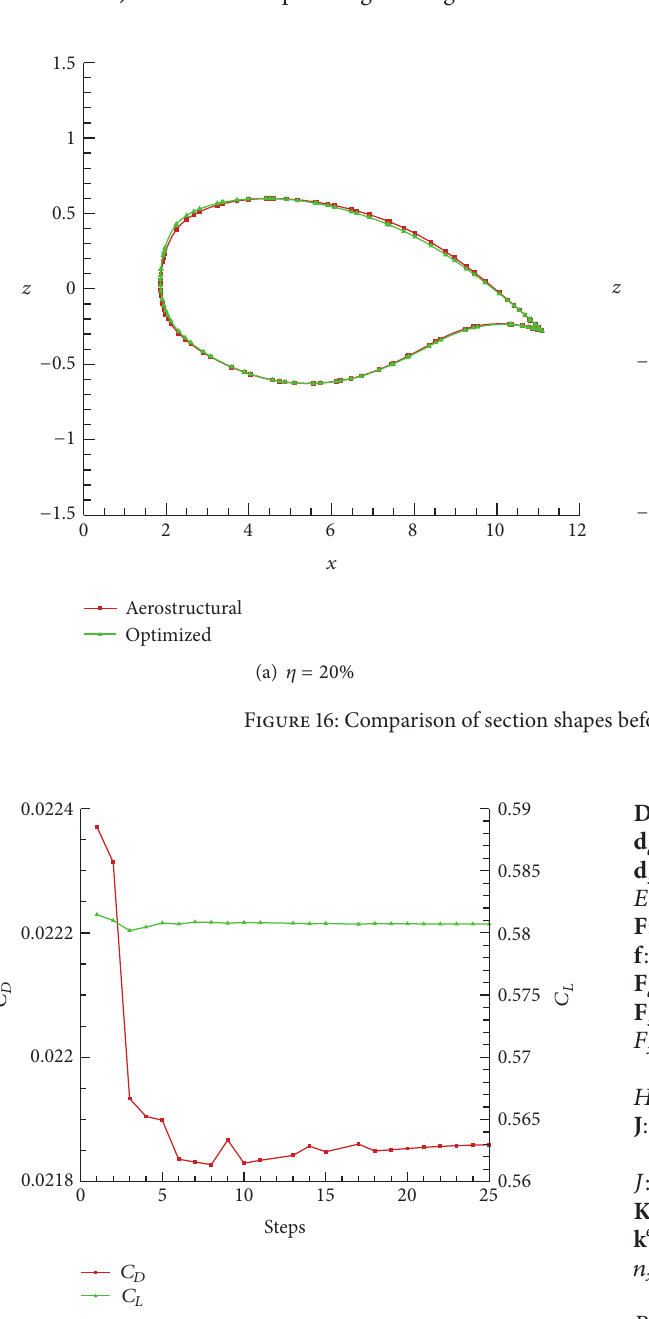
Figure 17: Convergence history for flexible wing